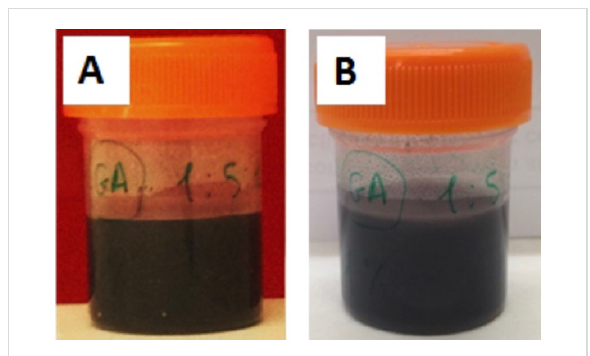
Figure 2: Photographs of dispersions of 1 wt % of a multicomponent bionanocomposite (composition of sample Film-1 given in Table 2); A) freshly prepared and B) after five months.